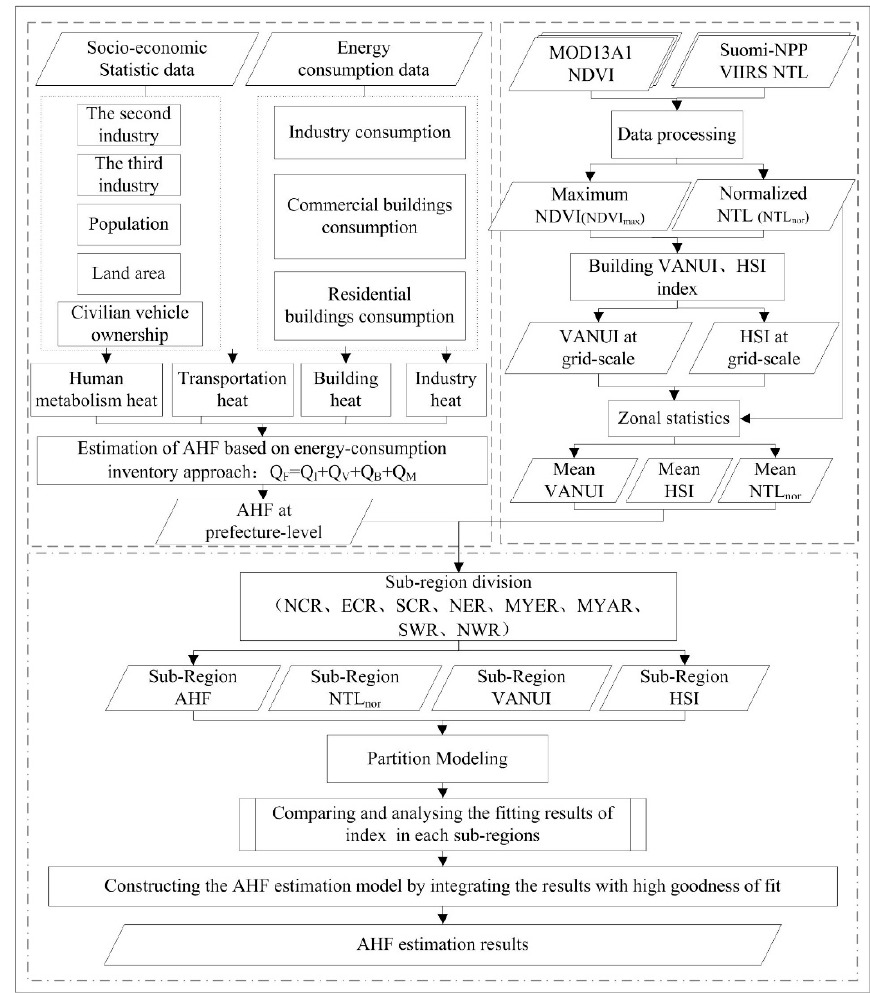
Figure 2. Flowchart of the gridded anthropogenic heat flux (AHF) estimation scheme.